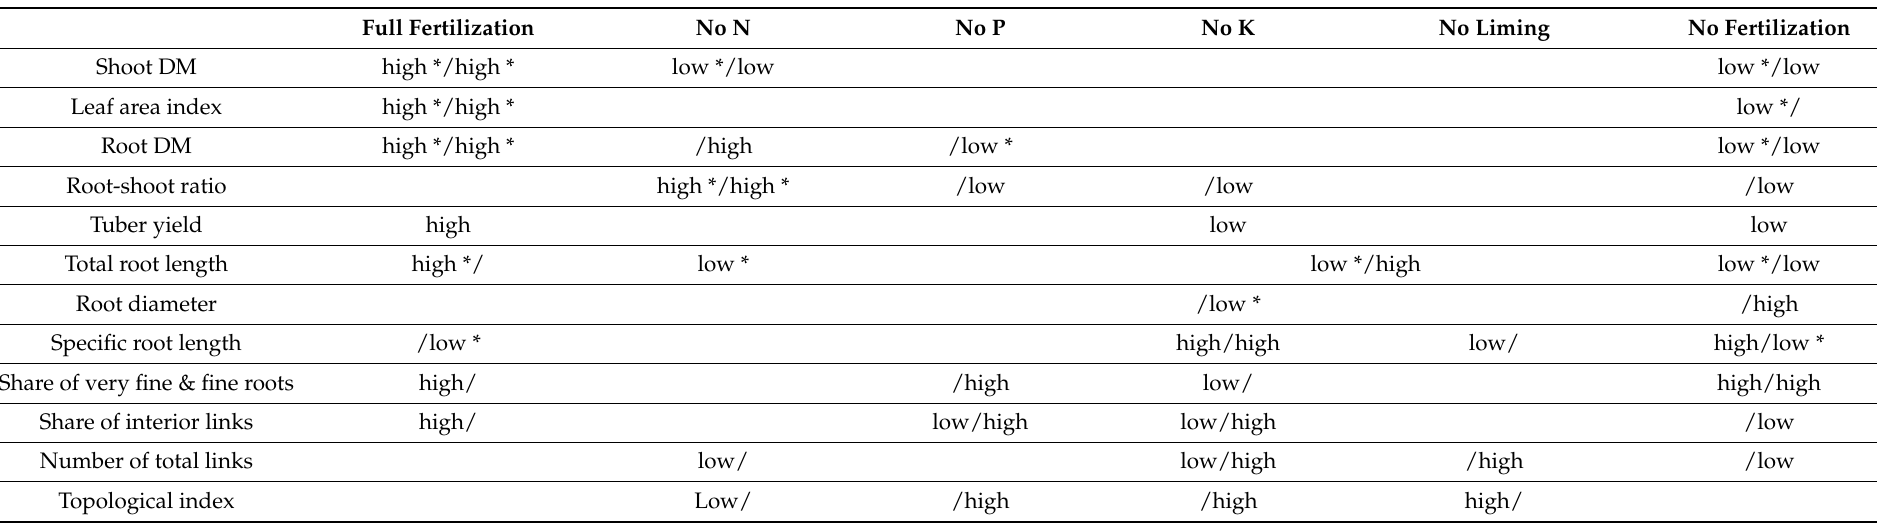
Table 5. The matrix presents the observed strategies of shoot and root growth of sugar beet under optimally fertilized conditions and nutrient omission of sugar beet at the long-term fertilizer experiment Dikopshof in 2019. The symbol/divides into strategy in the early growth stages from strategy in the late growth stage. Significant differences are marked with *, others are non-significant